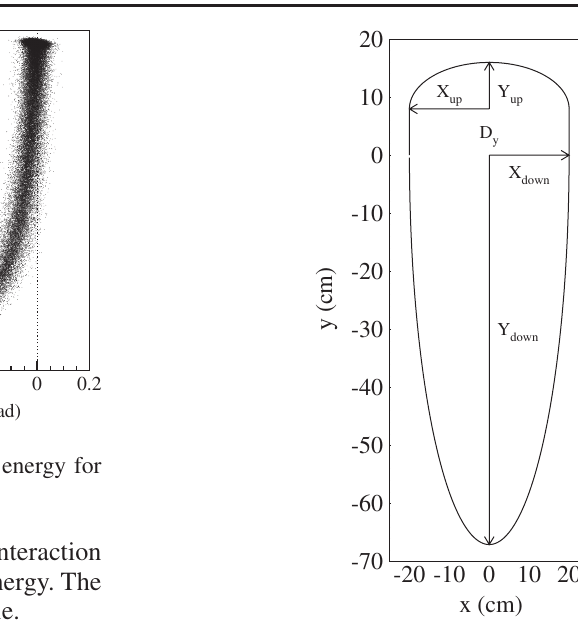
FIG. 16. Schematic drawing of the vacuum chamber for the disrupted beam and the beamstrahlung photons (here 75 m after the interaction point): two half ellipses with the same horizontal semiaxis but different vertical semiaxis ( Y separated by a distance equal to D